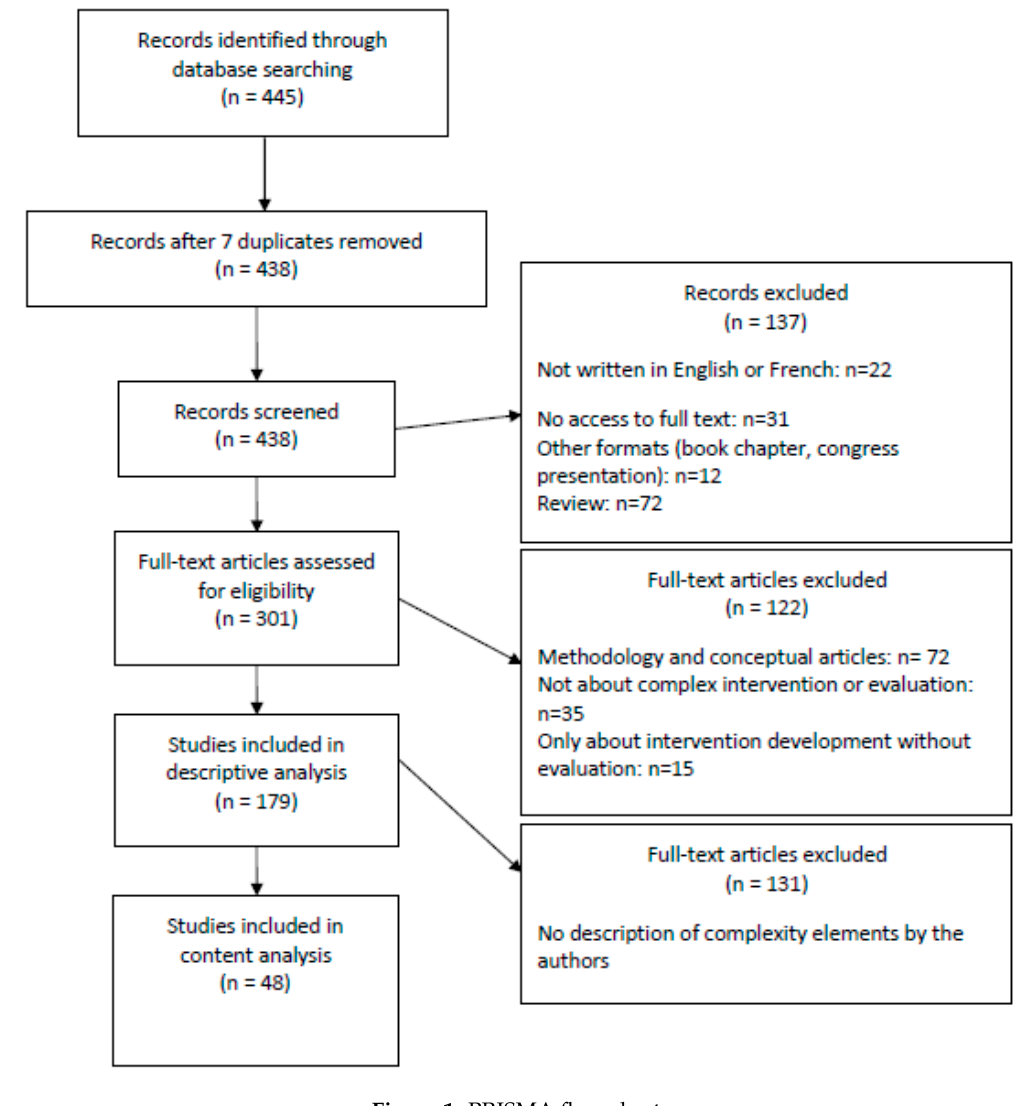
Figure 1. PRISMA flow chart. Table 1. List of included